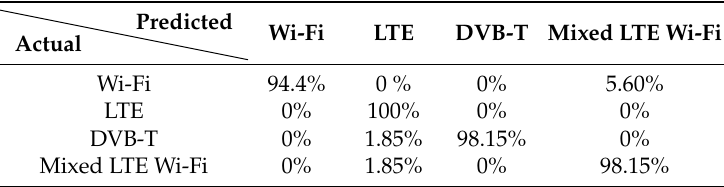
Table 3. Confusion matrix of the extended validation for N = 20, T = 1 s; noise and unknown signal classes are omitted because of all being 0%